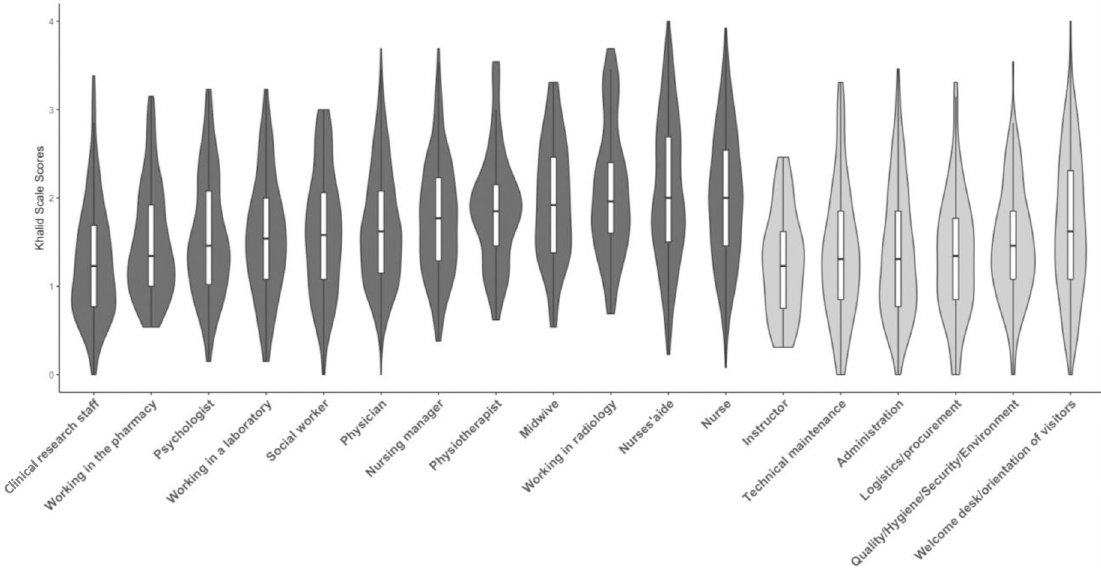
Fig 4. Histogram and quartiles of scores on Khalid’s scale, by profession. Medical / caregiving professions are shown in dark grey, and non-medical professions in light grey.